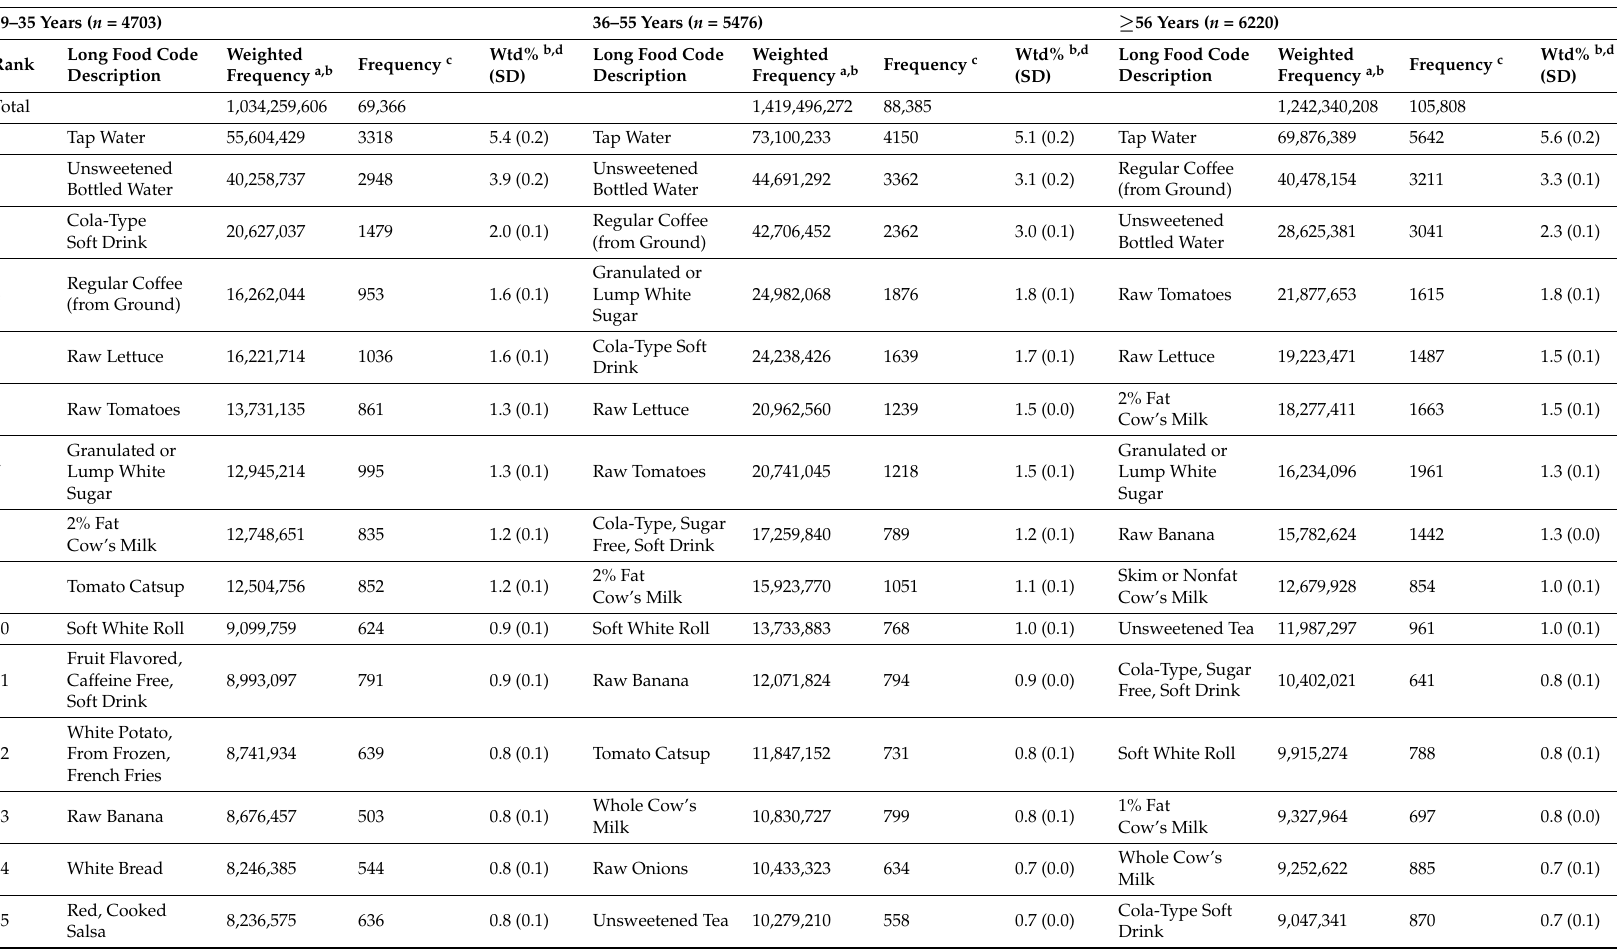
Table 3. Top 25 most frequently consumed foods or beverages, unweighted and weighted frequency of reported foods or beverages, percent of reported foods or beverages, and standard error of percent of reported foods or beverages among all reported foods or beverages for U.S. adults aged ≥ 19 years from 2007–2012 NHANES